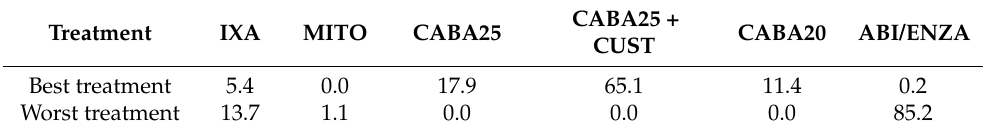
Table 5. Ranking of treatments regarding overall